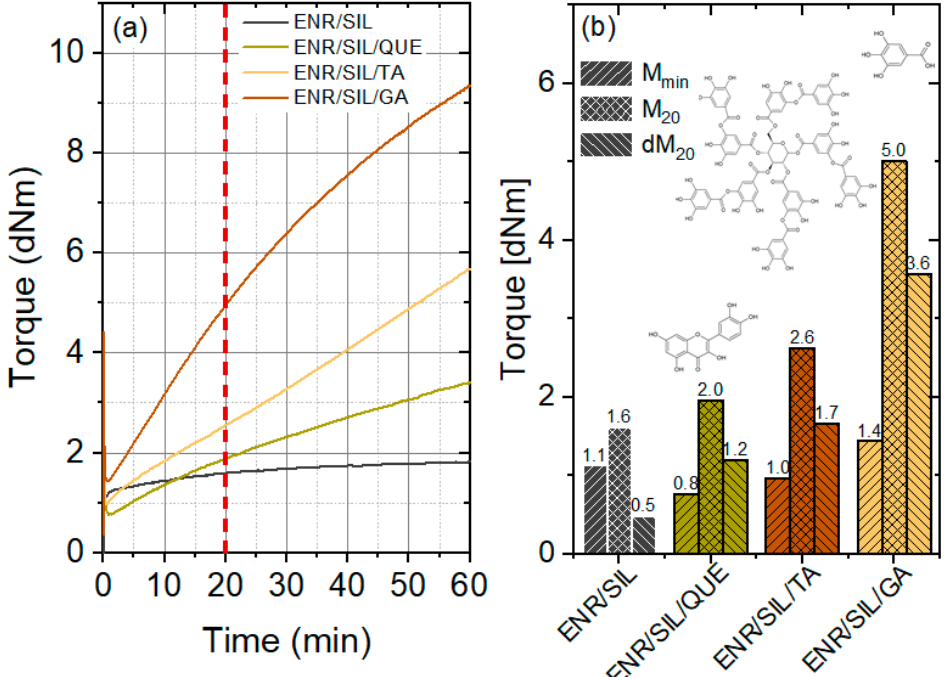
Figure 3. Analysis of curing effectiveness of ENR/silica materials containing natural phenolic compounds as a function of time ( a ) and values of the minimal torque (Mmin), torque at 20th min of vulcanizing (M 20 ), and torque increase at 20th min of vulcanizing (dM 20 ) of the same materials ( b ).